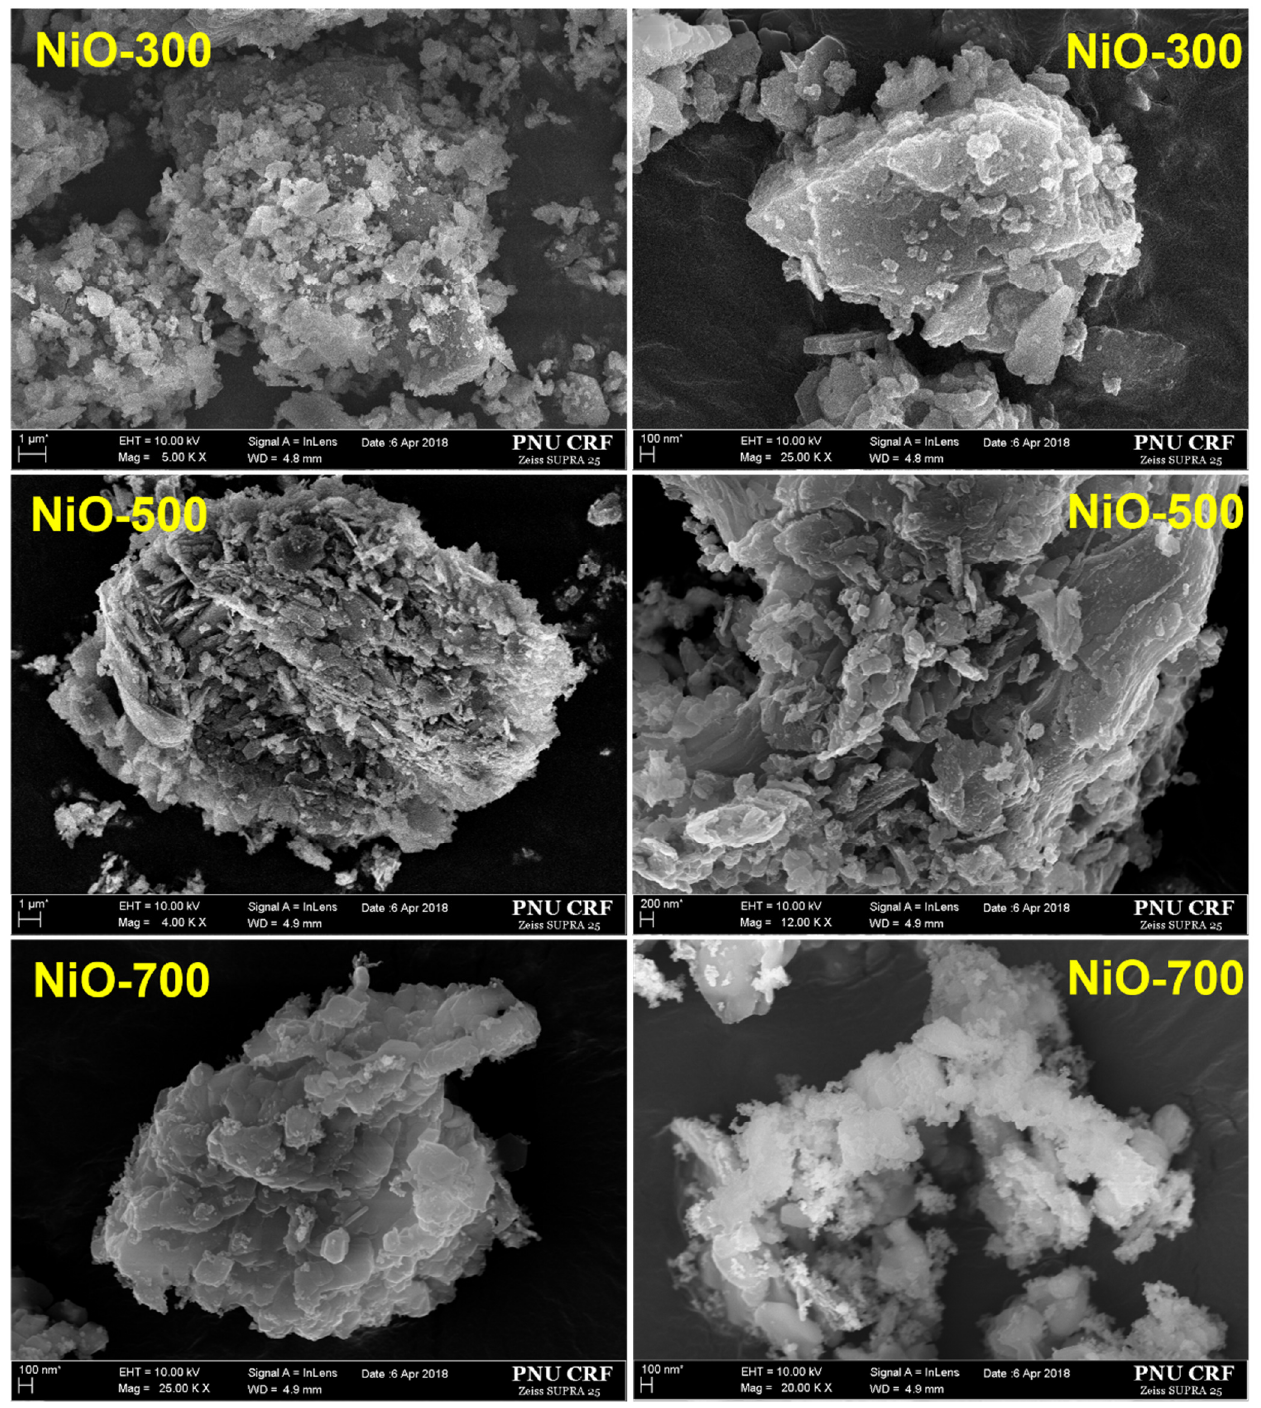
Figure 3. FE-SEM photographs of the obtained NiO materials with different calcination tempera-